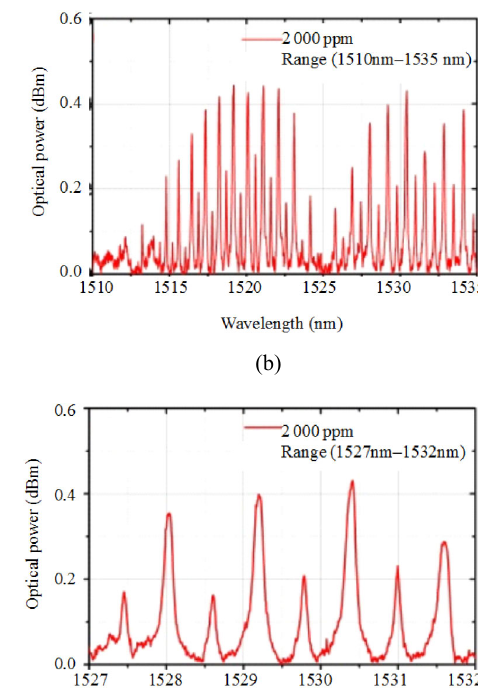
Fig. 6 Comparison of NH 3 of different concentrations after data process: (a) 0.5% NH 3 (1 510 nm–1 535 nm), (b) 1% NH 3 (1 510 nm